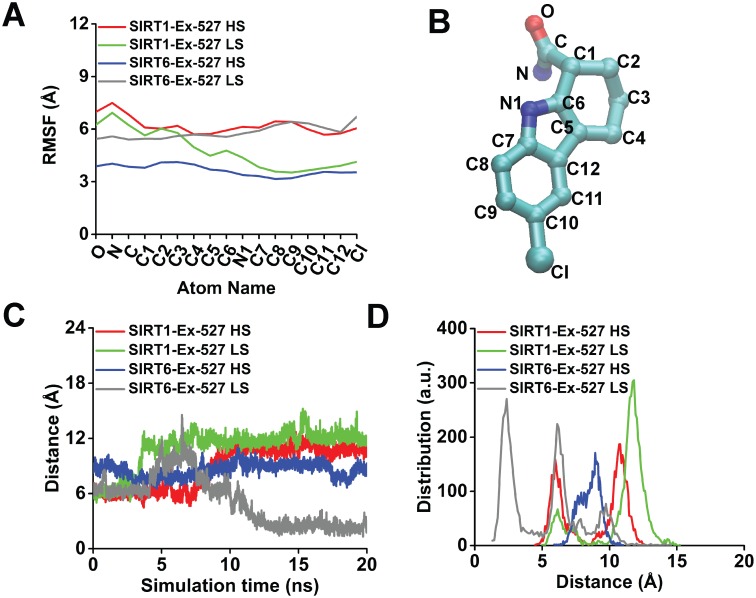
Ex-527 docked to SIRT6, displayed less flexibility and remained in closer proximity to the hydrophobic pocket compared with Ex-527 of SIRT1.(A) RMSF of Ex-527 atoms in SIRT6-Ex-527 complex under high salt (HS) conditions (blue) showed lower flexibility, compared with its positive control, Ex-527 of SIRT1-Ex-527 complex (red) during 20 ns of MD simulations. Under low salt, Ex-527 of SIRT1 (green) had shown lower flexibility than Ex-527 of SIRT6 (gray), for most of the residues. (B) Name of all atoms of Ex-527 were given for clear representation of the results in (A). (C) The distance between the center of mass of Ex-527 and the center of mass of the hydrophobic pocket residues of SIRT6 under high salt concentration (blue) persisted around 7 to 10 Å range, while its corresponding positive control (red) had a clear shift from 6 to 12 Å after ~7 ns of MD simulations. Under low salt, distance between Ex-527 to SIRT6 (gray) even got shortened, while that of SIRT1 (green) was lengthened, compared with Ex-527 of SIRT6 under high salt (blue). (D) Distance distribution vs. distance of Ex-527 to the hydrophobic pockets of all complexes in all simulations were given for clear representation of the distance shifts during the MD simulations in (C). a.u. refers to the arbitrary units, indicating the number of times that each distance was encountered during the simulations. Results obtained from this figure was based on the trends shown and statistical analyses given in S6 Fig. Å: Angstrom, C: Carbon, O: Oxygen, N: Nitrogen, Cl: Chloride